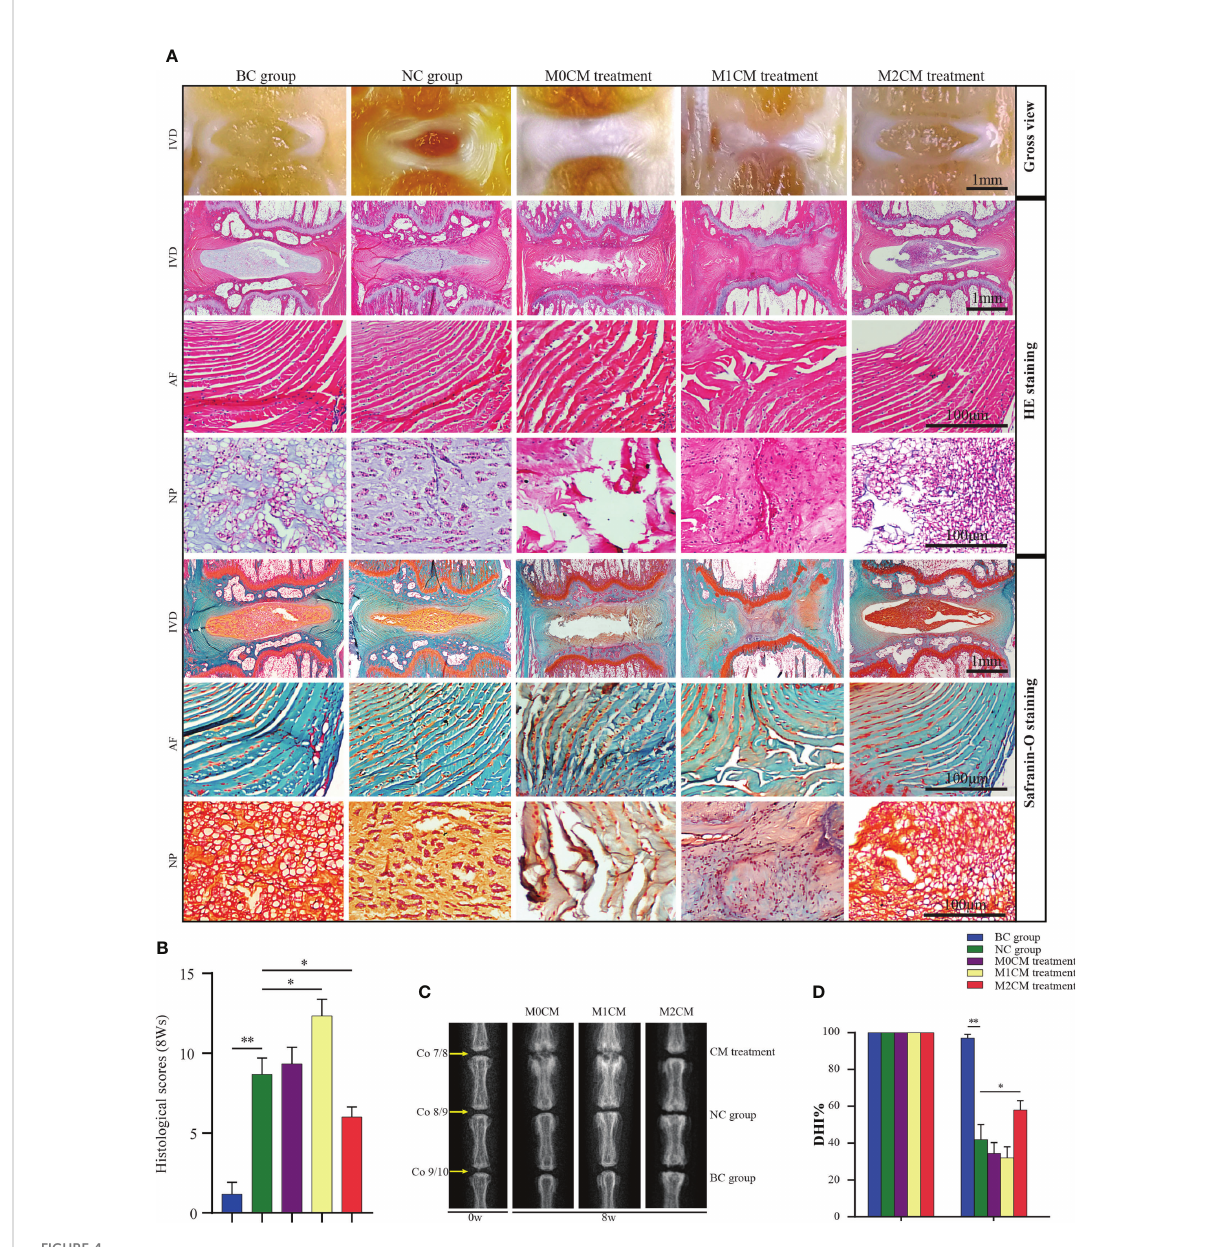
FIGURE 4 Effect of macrophage polarization on the radiographic changes and histological scores corresponding to rat coccygeal IVDs. (A) Representative general view, HE staining and Safranin-O/Fast Green staining images of rat coccygeal IVDs corresponding to different treatment groups (Coronal position). (B) Histological grading score showing changes in IVD at 8 weeks after initial puncture and different treatments. (C) Representative X-ray images showing rat coccygeal IVDs in different treatment groups and (D) , %DHI values showing changes in IVD at 8 weeks after initial puncture for different treatments. All data are expressed as the mean ± SD. n = 6, *P < 0.05, **P < 0.01. IVD, intervertebral disc; TNF- a , tumor necrosis factor- a ; CM, condition medium; HE, Hematoxylin and eosin; DHI, disc height